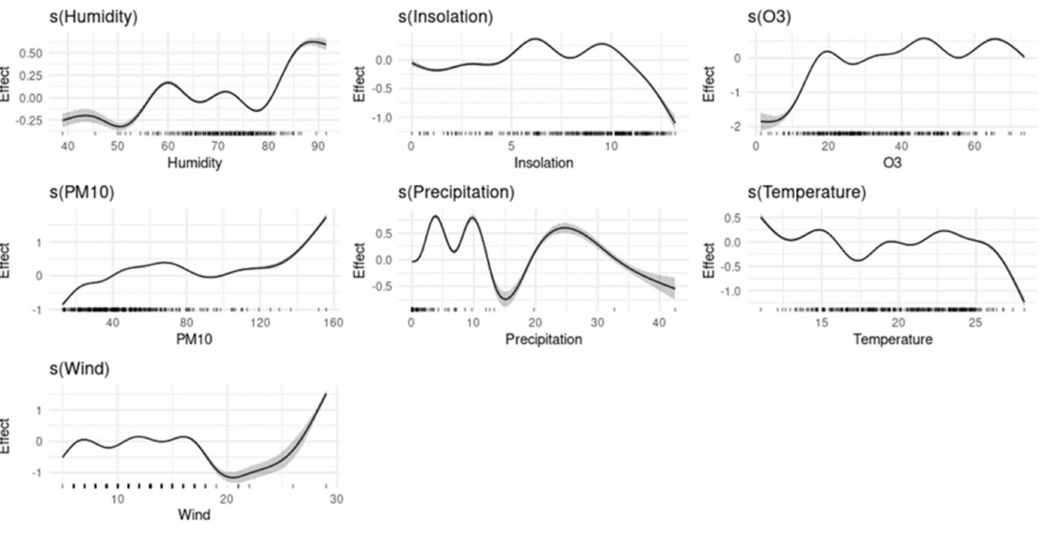
Figure 4. Exposure − response relationship between temperature, humidity, precipitation, wind, insolation, O 3 , PM10, and daily confirmed COVID − 19 cases in Casablanca region from 2 March